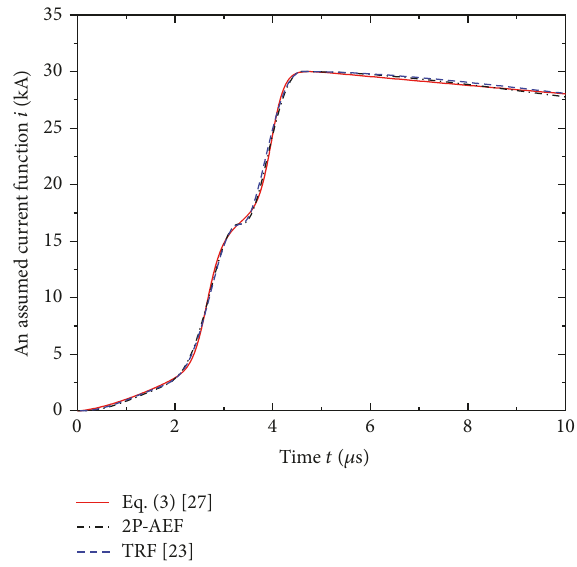
Figure 2: An assumed two-peaked current waveshape [27], TRF [23], and 2P-AEF(2,1,2).